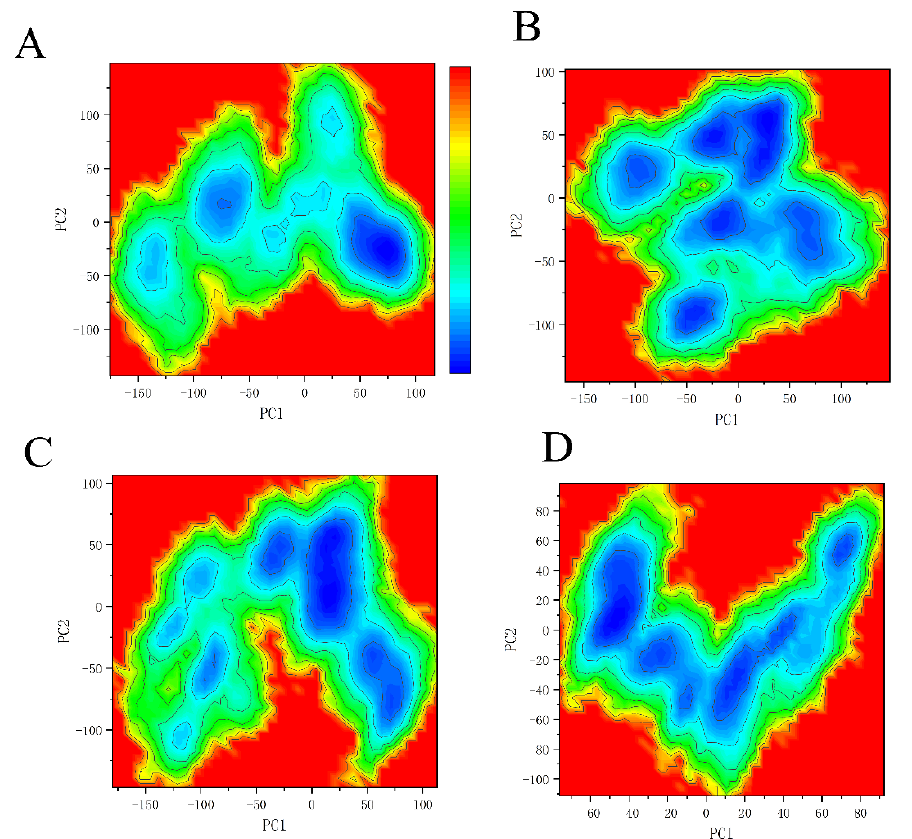
Figure 7. Free energy landscapes of system SHP2 ( A ), system EPIYA-D-N ( B ), system EPIYA-C-N ( C ), and system EPIYA- C-DUAL ( D ).